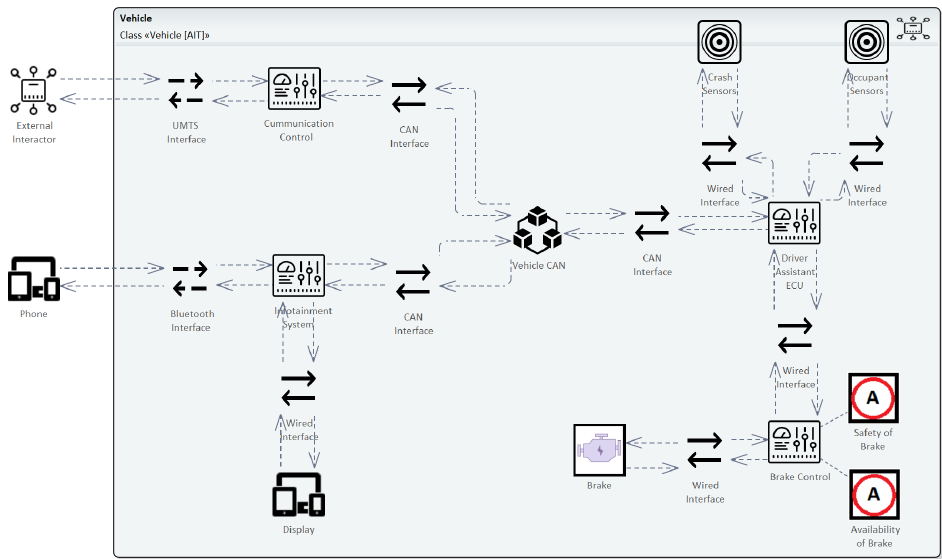
Figure 13. Diagram of the automotive system architecture including